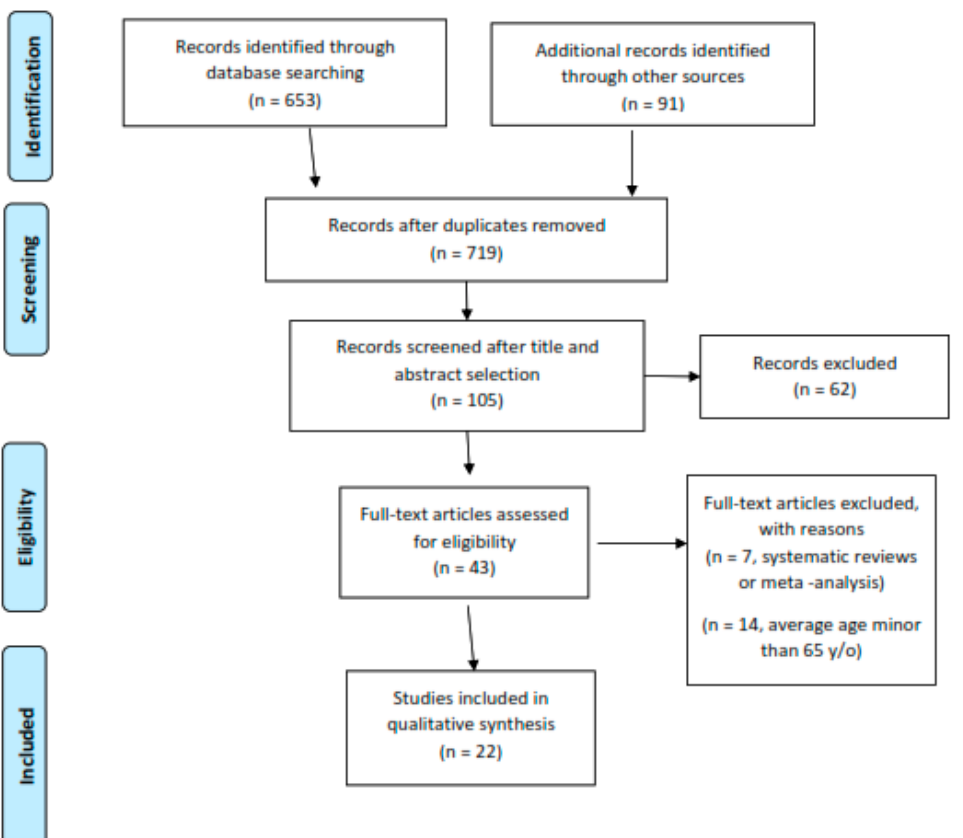
Figure 1. Flow chart of the study inclusion process.